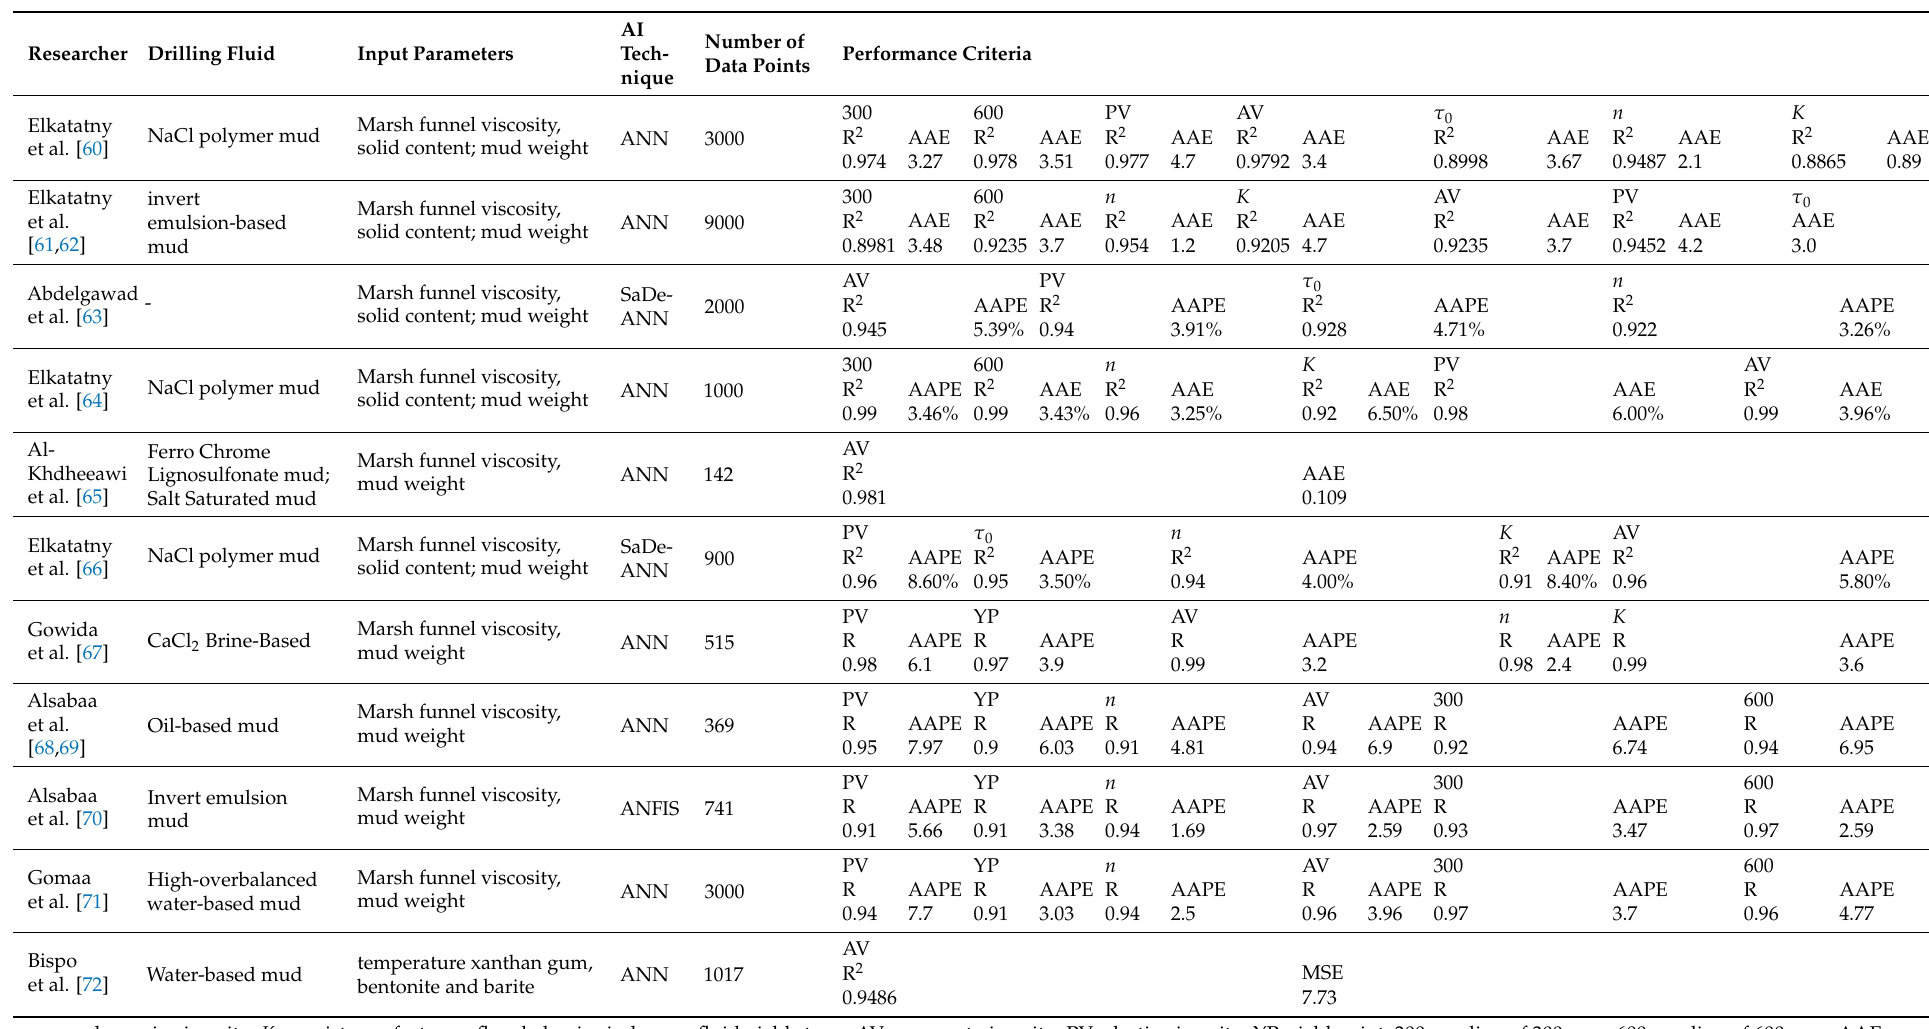
Table 2. Comparative studies of various AI techniques conducted by previous